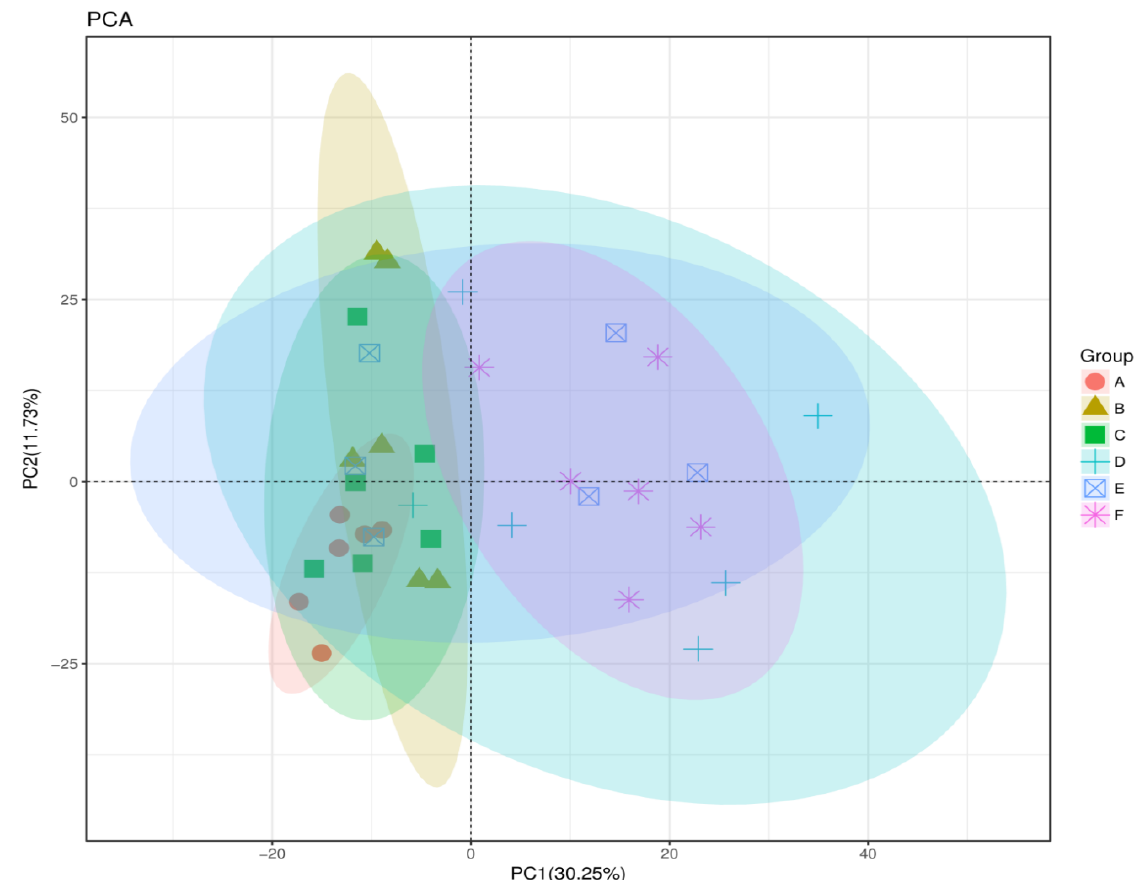
Figure 6. Microbiota composition among different groups at the genus level. PCA analyses by R software test among the corn-fed groups and wheat-fed groups. The degree of clustering reflects the similarity of the groups. The cecal microbiotas of the six groups could be divided into clusters according to community composition.